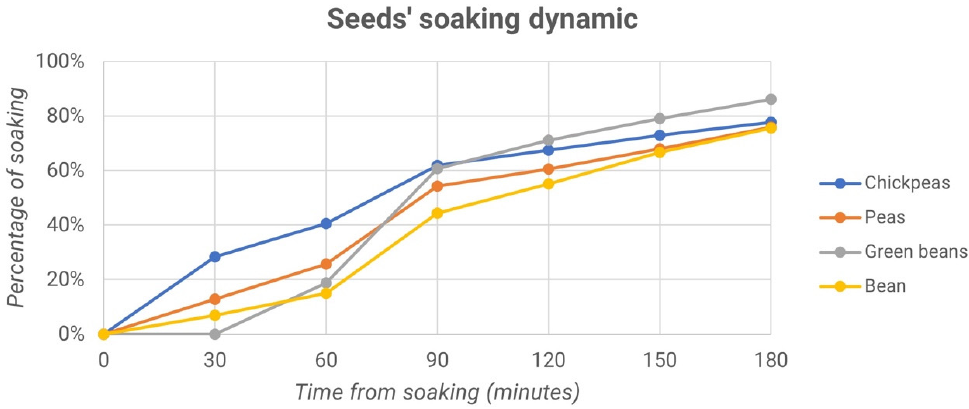
Figure 14. Percentage of soaking vs. time from soaking for chickpeas, peas, green beans and beans.